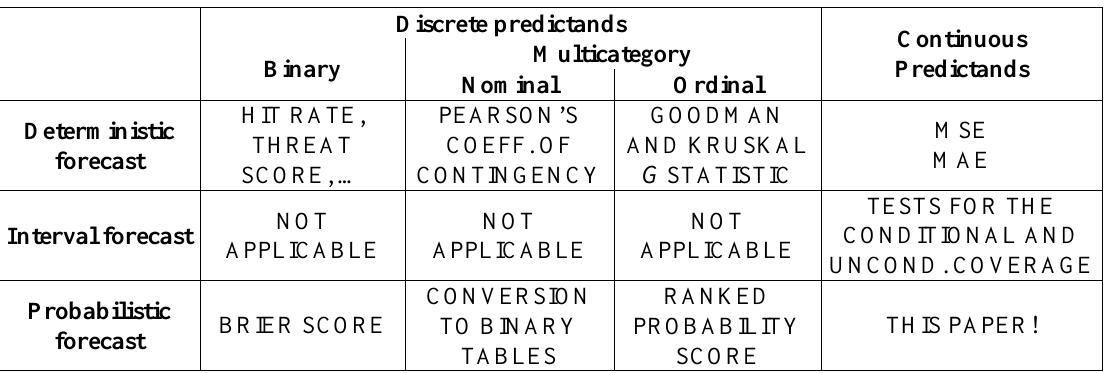
Table 1. Forecast verification tools, subdivided by the type of predicted variable (columns) and the forecast outcome (rows). We refer to Sect. 2 for details and references about the